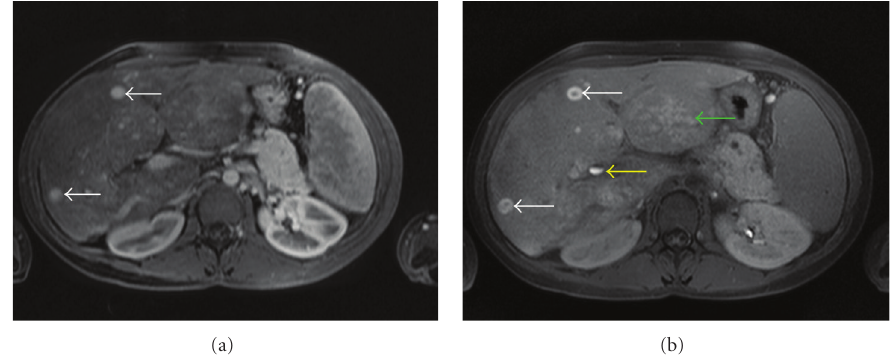
Figure 2: As the multiple lesions show a homogeneous enhancement in portal venous phase (a) (T1-weighted VIBE sequence), there is a central “washout” with a peripheral pooling of contrast agent (white arrow) in late phase (b) (T1-weighted FLASH sequence, 20 min p.i.). This is likely to be due to a missing washin of the more central parts. Additionally, there is an evidence of an inhomogeneous hilar pooling of the contrast agent, predominantly in the left liver lobe (green arrow). Contrast agent level in the ductus hepatocholedochus (yellow arrow).